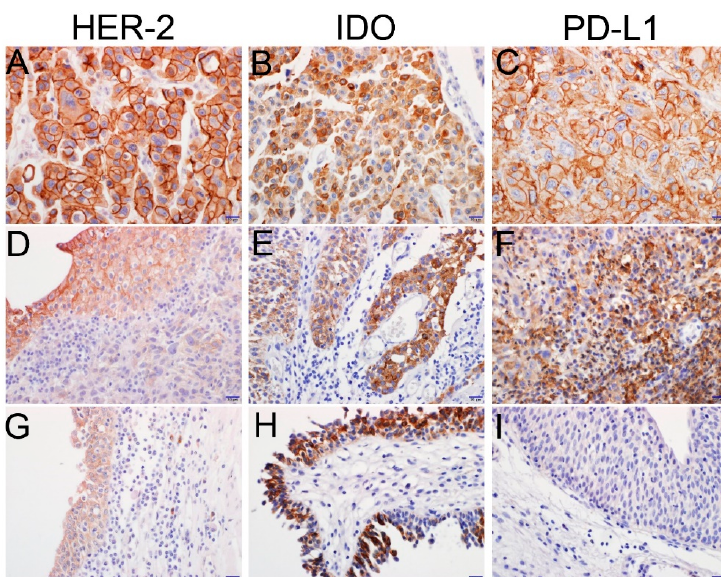
Figure 1. Representative images of HER2, IDO, and PD-L1 immunohistochemical staining in urothelial carcinoma of the bladder (UCB). ( A–C ) Invasive cancer cells with strongly positive expressions of HER2, IDO, and PD-L1. ( D ) Intermediate positive expression of HER2 in low-grade noninvasive urothelial tumor (left upper) and very weakly positive expression of HER2 in invasive cancer cells (right lower). ( E ) Intermediate positive expression of IDO in a low-grade noninvasive urothelial tumor (left) and strongly positive expression of IDO in a high-grade urothelial tumor (right). ( F ) Strongly positive expression of PD-L1 in intra-tumoral immune cells. ( G ) Weakly positive expression of HER2 in reactive urothelial epithelium. ( H ) Strongly positive in situ expression of IDO in urothelial carcinoma. ( I ) Negative expression of PD-L1 in reactive urothelium (scale bar = 20 μ m).